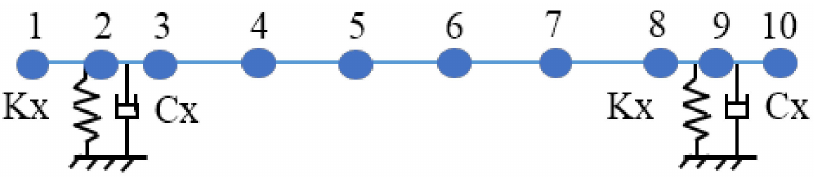
Figure 5. Theoretical model of the numerical example [47]. (1-10-ten lumped masses, Kx-stiffness of bearing, Cx-damping of